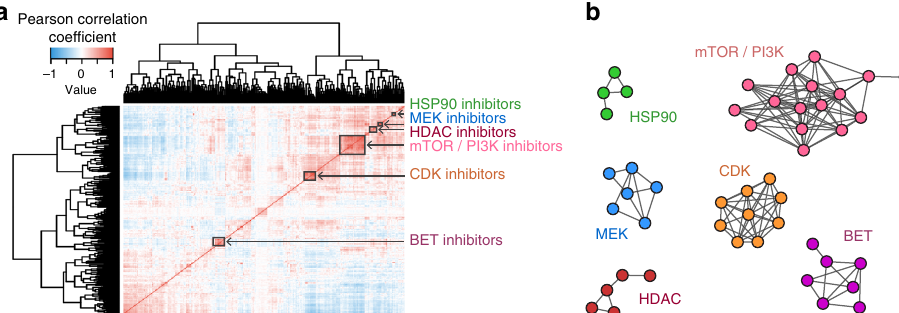
Fig. 4 L1000 consensus signatures re fl ect molecule mechanism of action. a Correlation matrix of the 285 LINCS consensus signatures and the 14 GBM consensus signatures. The LINCS L1000 dataset was merged with the GBM L1000 dataset, and TCSs were calculated and used to produce the correlation matrix. The red clusters along the diagonal indicate compounds that have highly correlated consensus signatures. b Networks of highly correlated LINCS small molecules. A connection indicates a 0.7 or above Pearson correlation of their consensus gene signatures. The compounds were colored and labeled based on their mechanism of action as identi fi ed through a literature search. Compound names and mechanisms of action can be found in Supplementary